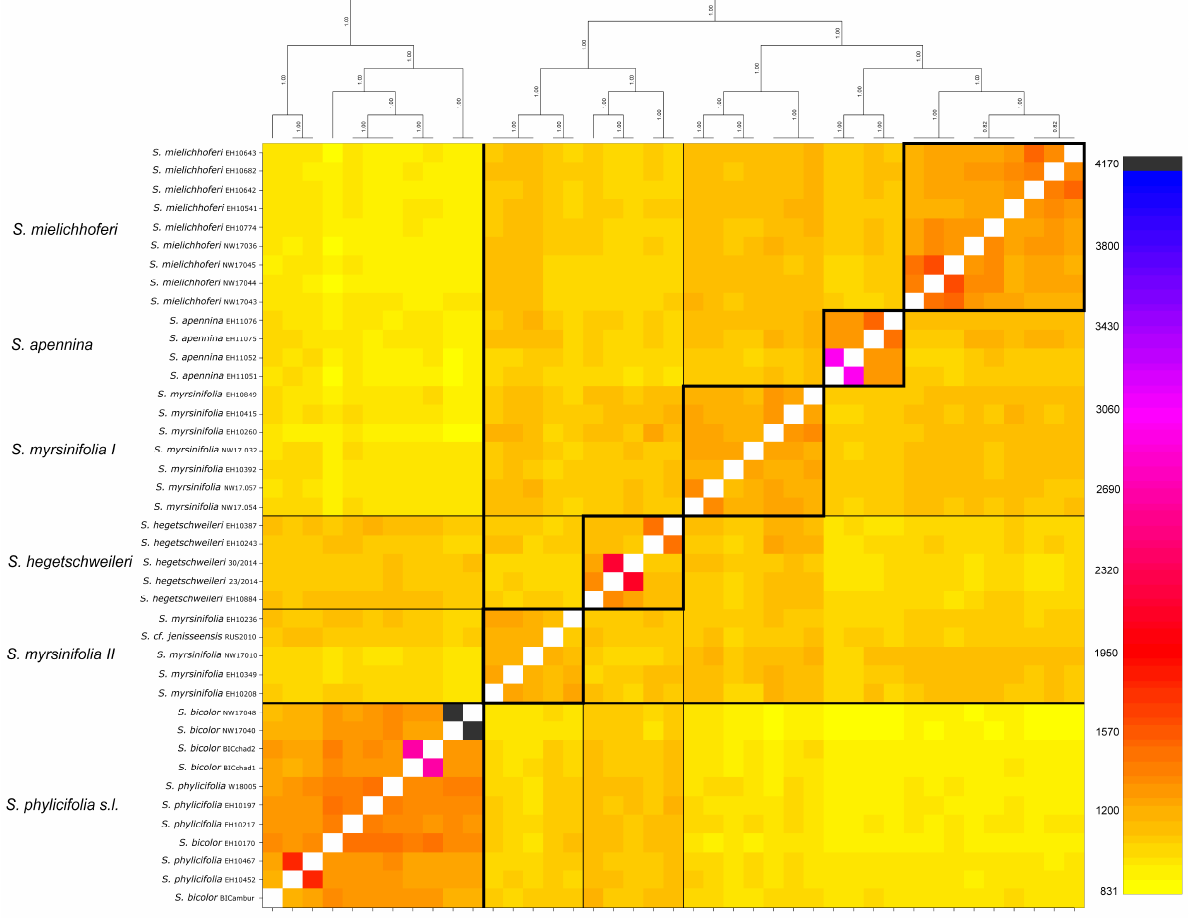
Figure 3. Co-ancestry analysis with fineRADstructure of 43 samples belonging to the sections Nigricantes and Phylicifoliae s.l. based on 49,754 RAD loci shared by at least 10 individuals. The amount of co-ancestry is illustrated by the color shade (legend left side). The sections and species are clearly separated. Salix myrsinifolia appears in two groups, one including samples from the European Alps ( S. myrsinifolia I ) and the other group includes samples from Fennoscandia and S. cf. jenisseensis from Russia ( S. myrsinifolia II ). Salix bicolor is included in S. phylicifolia . Detailed clade-wise results are presented in Supplementary Figure S3.